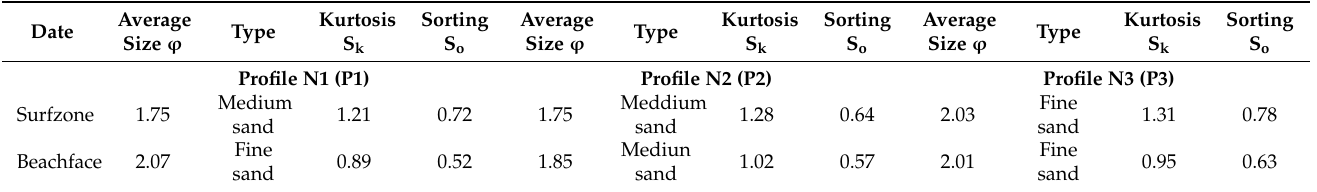
Figure 9. Four-dimensional plotting of statistical parameters of sediments at the surf zone ( A ) ( left ) and at the beach-face zone ( B ) ( right ). Main parameters plotted are average particle diameter (d 50 ), kurtosis (S k ), and sorting (S 0 ). Color bar indicates the evolution in time, from March 2011 (dark blue) until July 2013 (yellow). Table 4. Statistical parameters of the beach-face and surf zone sediment. Mean values, kurtosis, and sorting (values lower than 1.6 indicate a good classification, values between 1.6 and 1.9 indicate a moderate or medium rating, and values above 1.9 indicate a poor rating) for the three beach profiles are presented in the table. In general, the surf zone sediment presented leptokurtosis and moderate sorting, while the beach-face sediment was mesokurtic and moderately well sorted. The average size in all profiles corresponded to medium or find